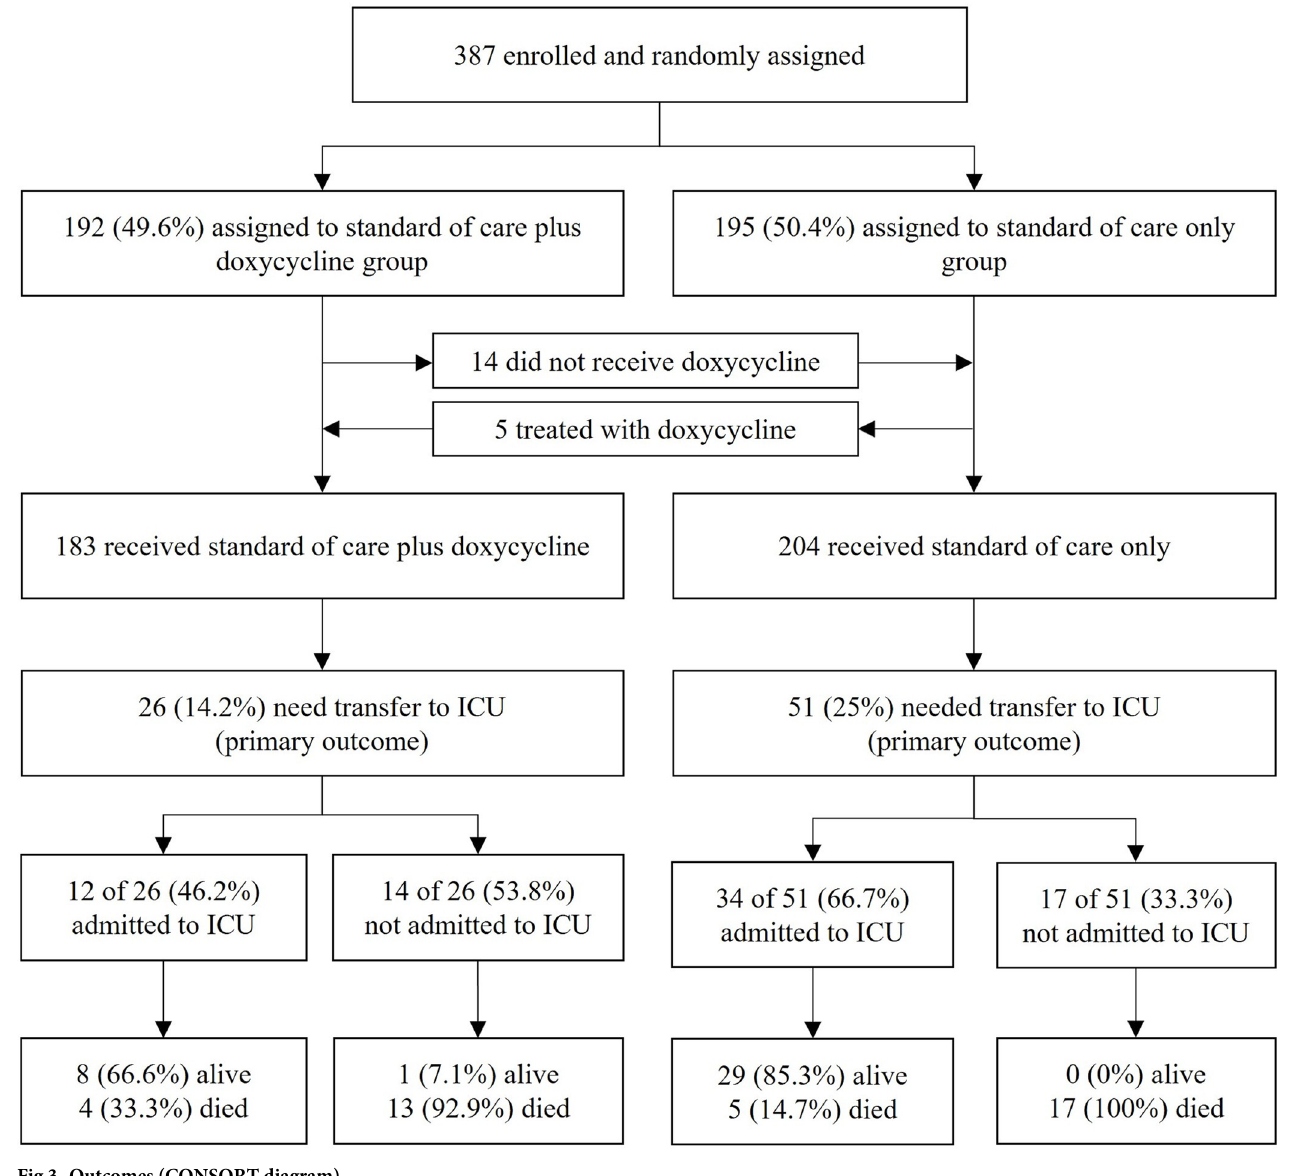
Fig 3. Outcomes (CONSORT